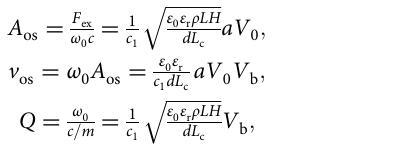
Fig. 4 Schematic representation of the ESL-oscillator. a Illustration of an elementary ESL-oscillator, where the two alternative voltages V 1 and V 2 are applied to the left and right electrodes, respectively. b Equivalent circuit diagram of the ESL-os c illator. c Relationship of the oscillating amplitude, A versus V 0 . In this case, the slider displacement must be less than ð L c – a Þ = 2 ¼ 1 μ m, which implies an excitation voltage of V 0 (cid:5) 3mV. d , e Relationship of the , and Q-factor versus the tunable electric bias, V , for V ¼ 2mV in d . The parameters used in the calculations are: maximum velocity in the oscillation, v os b 0 ε : 9 ; W ¼ L ¼ 4 μ m ; s ¼ 1 μ m ; a ¼ 1 μ m ; H ¼ 200nm ; d ¼ 20nm ; ρ ¼ 2 : 16gcm (cid:1) 3 ; and the damping is c ¼ 1 : 2 ´ 10 (cid:1) 11 kgs (cid:1) 1 33,34 . Details are provided in r ¼ 3 the Supplementary Note